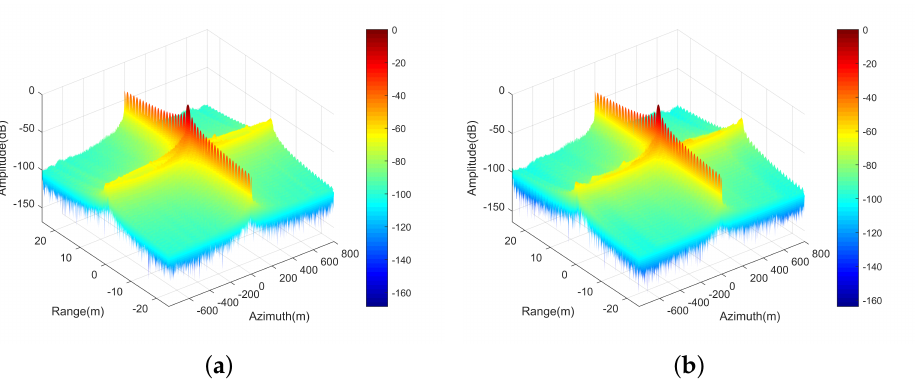
Figure 7. Imaging results of the point target when there is no error (by dB scale). ( a ) Reconstruction result by IDR; ( b ) Reconstruction result by